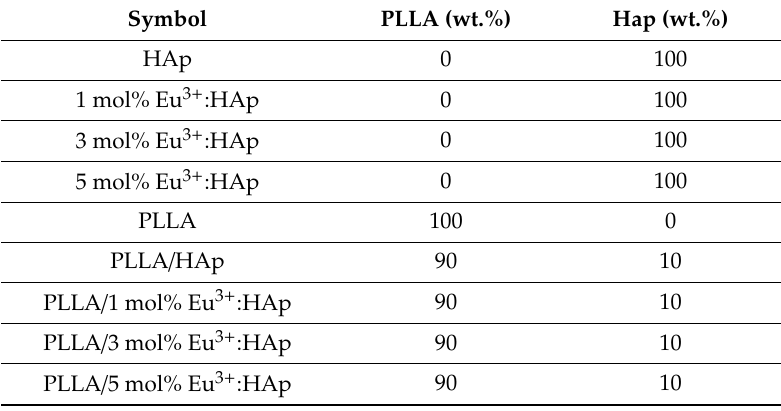
Table 1. Summary of the investigated materials. Symbol PLLA (wt.%) Hap